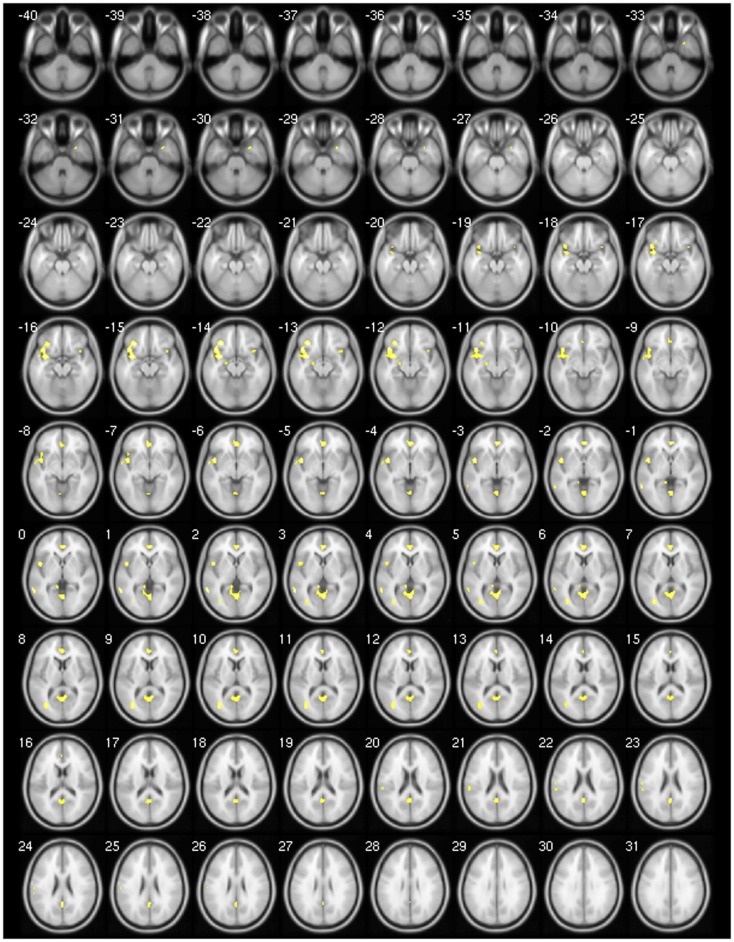
Areas showing decreased GM in axial slices using. p < 0.001.